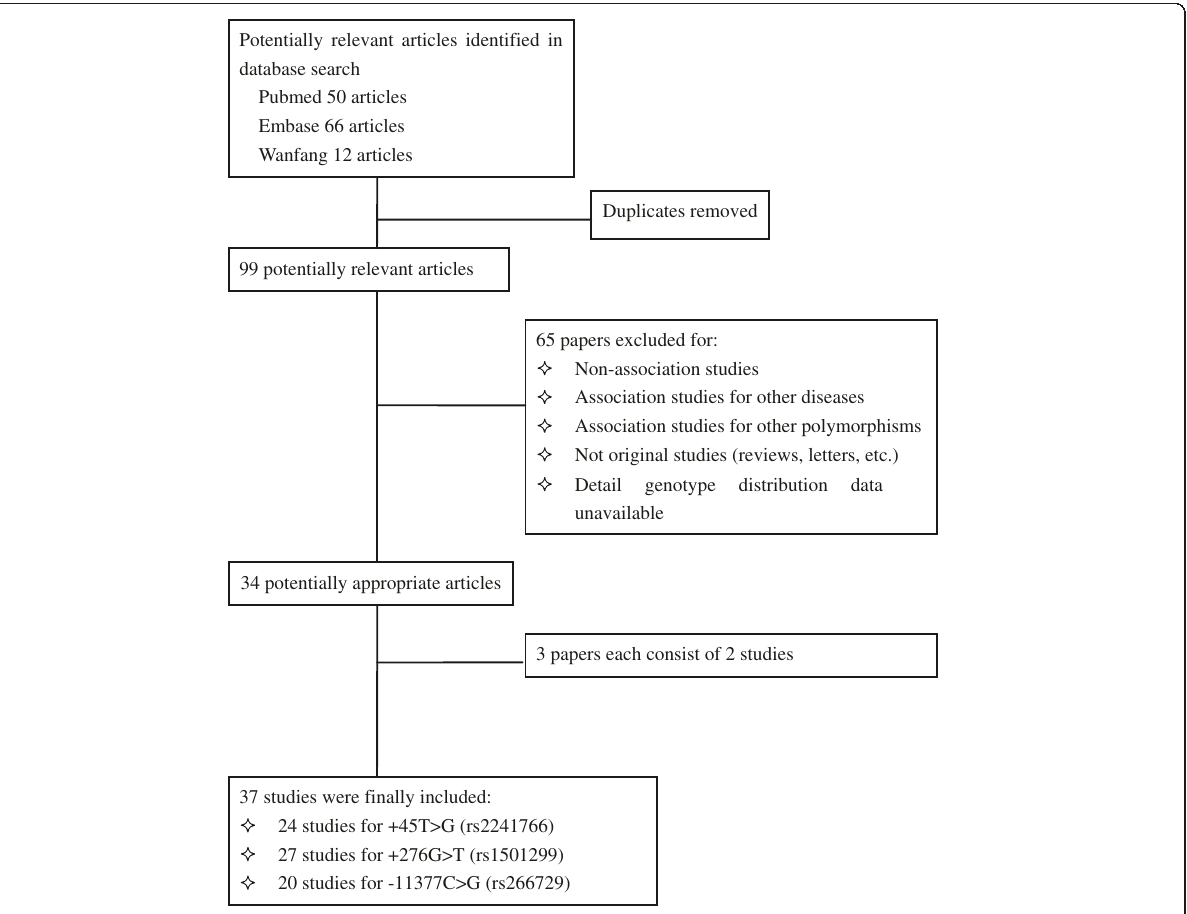
Figure 1 Flow diagram for study selection process in the meta-analysis of ADIPOQ gene polymorphisms and